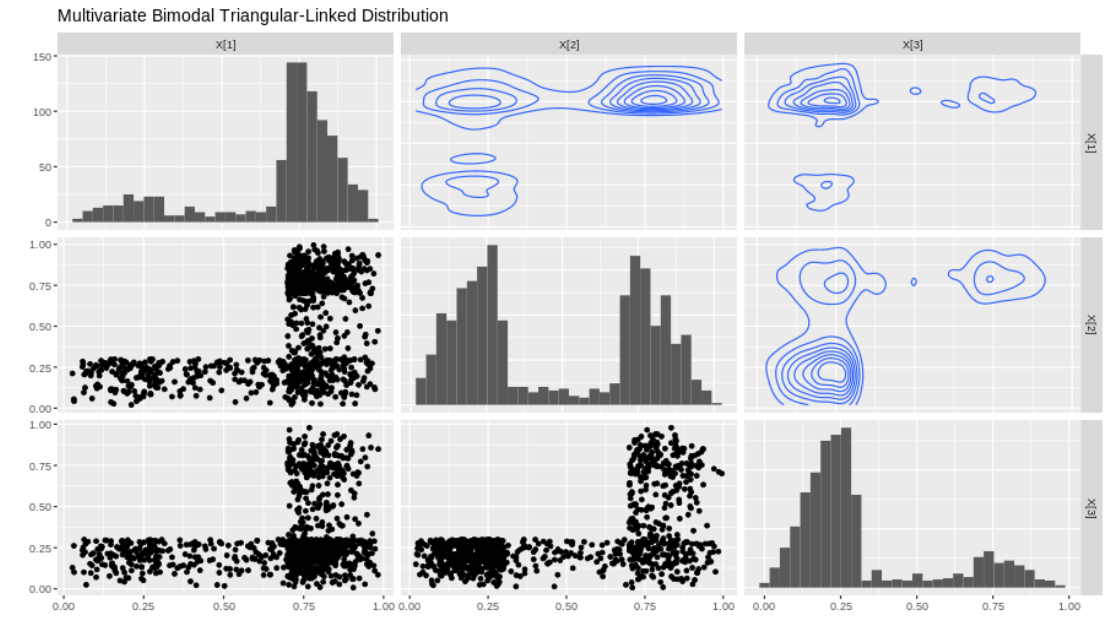
Figure 5. MVTL matrix plot with marginals X 1 , X 2 , X 3 .